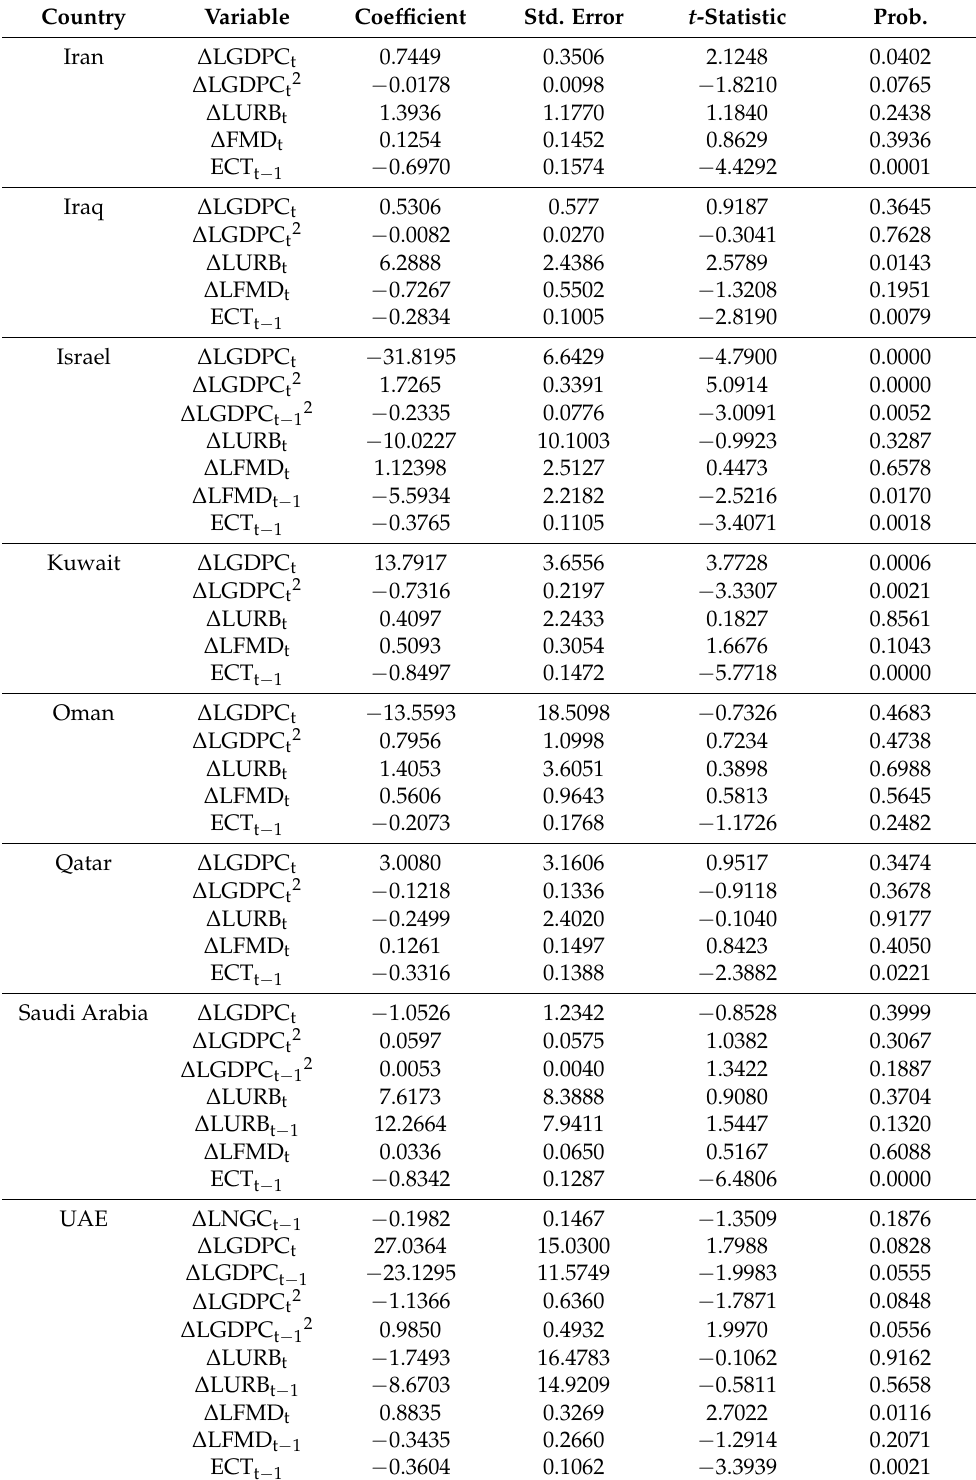
Table 4. Short-run results: ∆ LNGC t as the dependent